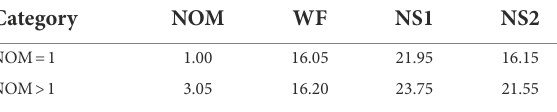
TABLE 2 Descriptive statistics of the lexical decision